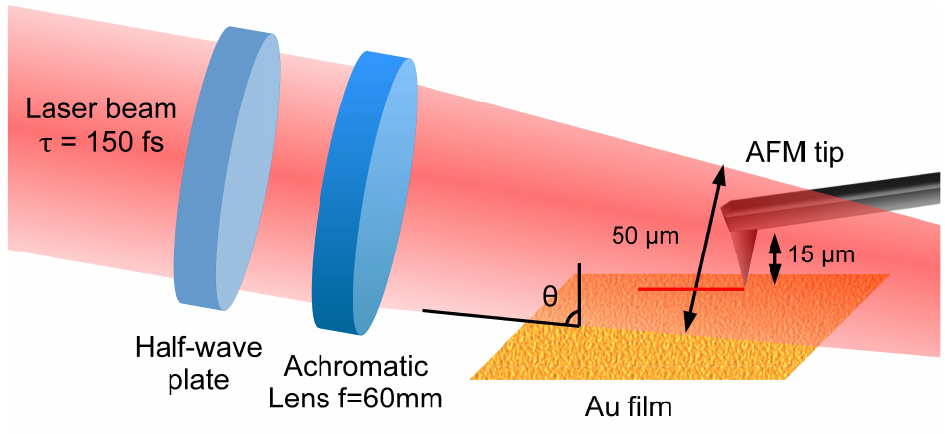
Figure 1. A scheme of the experimental setup. The p-polarized laser beam is focused onto an atomic force microscope (AFM) tip by an achromatic lens. The tip height is about 15 µ m, so the laser focal spot size (50 µ m) illuminates the tip entirely. A half-wave plate allows for controlling the laser polarization